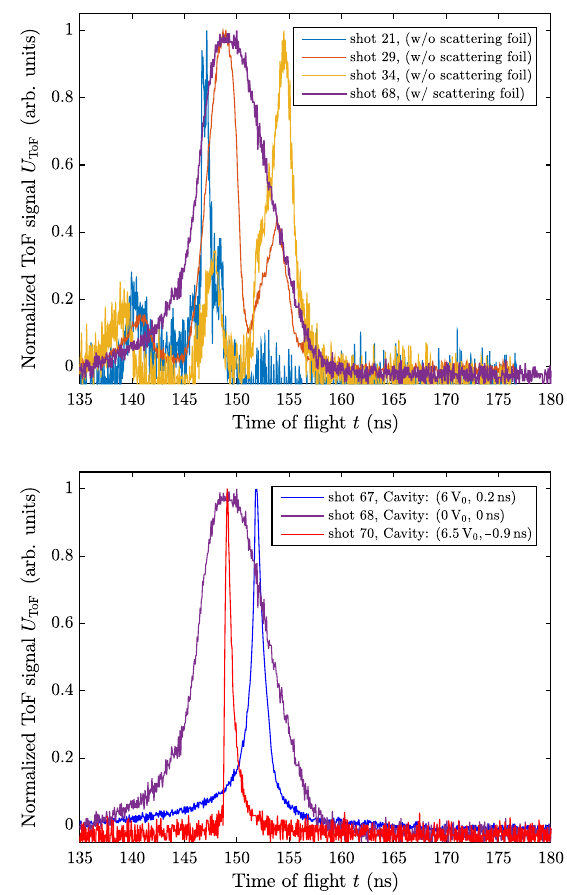
FIG. 7. Measurement of the temporal profile of the proton bunches with an ultrafast diamond detector at the end of the LIGHT beamline. The upper picture shows the results of different shots with and without a scattering foil in front of the second solenoid, whereas the lower picture shows the same measurement (with scattering foil) for different electric field strengths and phases of the